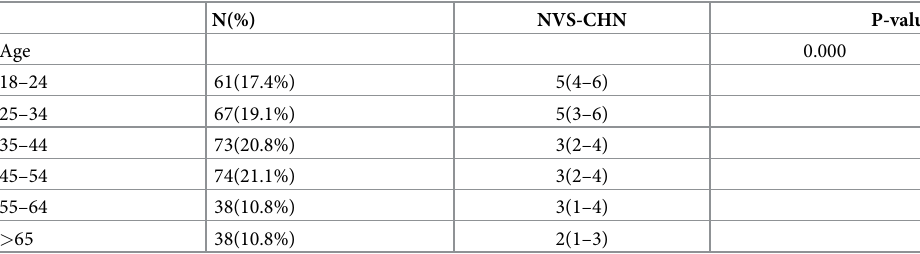
Table 1. NVS-CHN score comparison in different age groups (Median [IQR]).